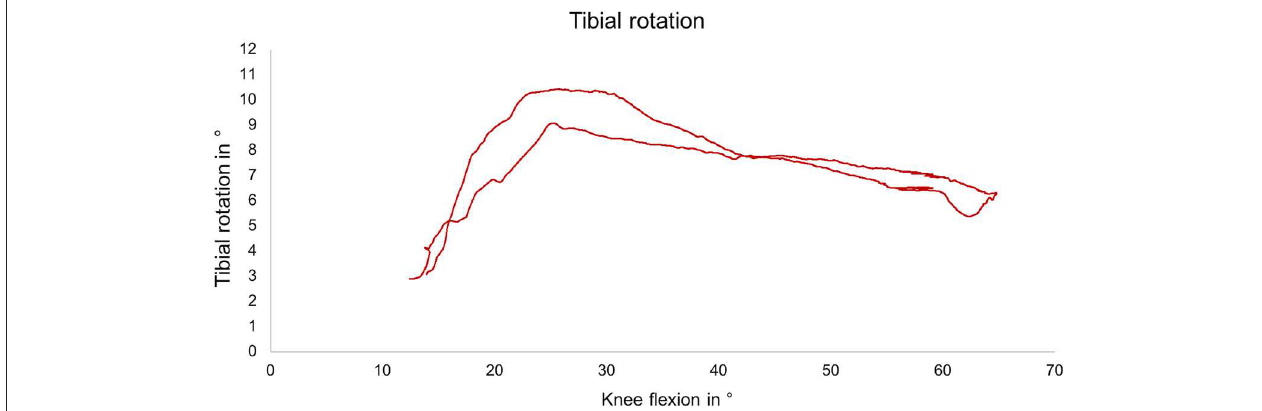
FIGURE 7 | Exemplary external tibial rotation as a function of the knee flexion angle during slow squat with muscle force simulation.